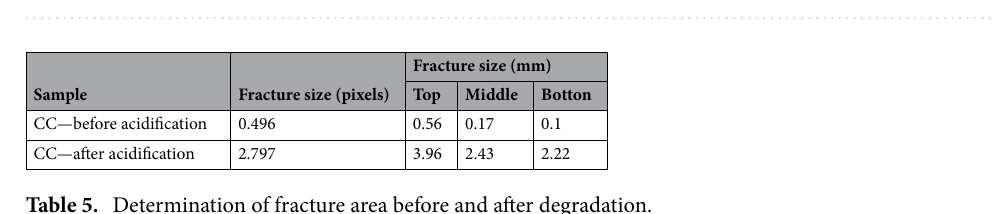
Figure 24. A 2D comparison of sample opening ( a ) before and ( b ) after degradation. Fracture opening distribution along the sample ( c ) before and ( d ) after degradation.